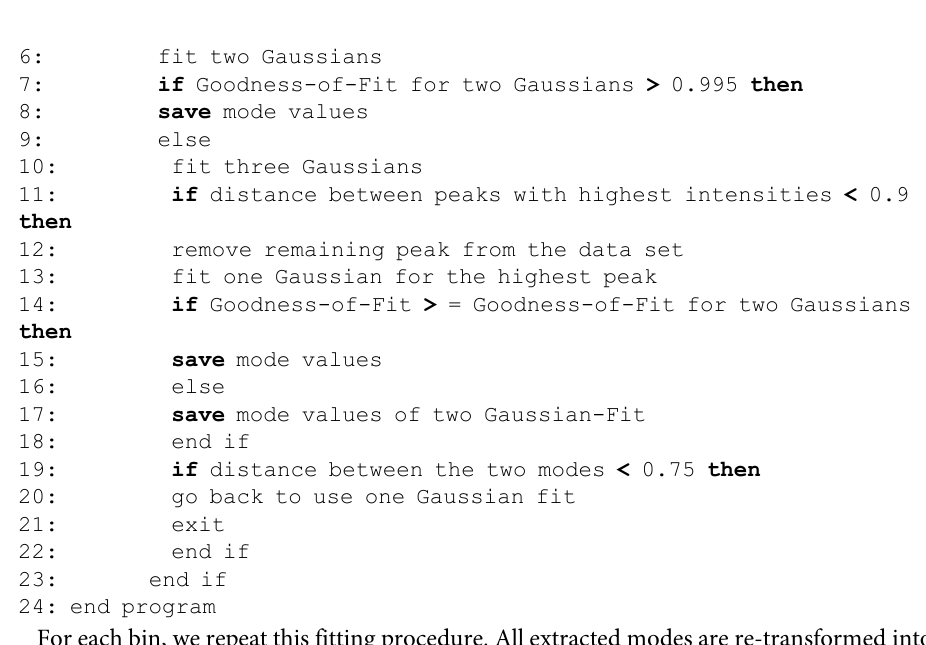
S1 Fig. Parameter drawing workflow. (TIF) S2 Fig. Co-transfection experiment and in silico simulations. (TIF) S3 Fig. In-silico simulations of a transient co-transfection with equimolar plasmid ratio. (TIF) S4 Fig. In-silico simulations of a transient co-transfection with nominal plasmid ratio.